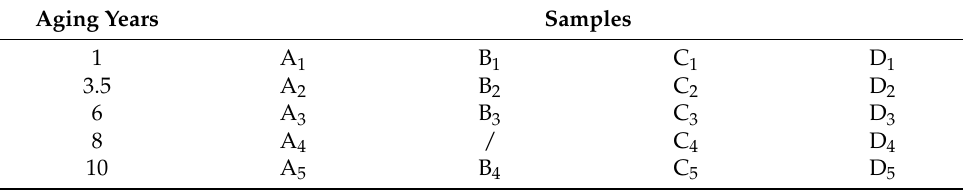
Table 2. Samples information of composite insulators from different manufacturers.